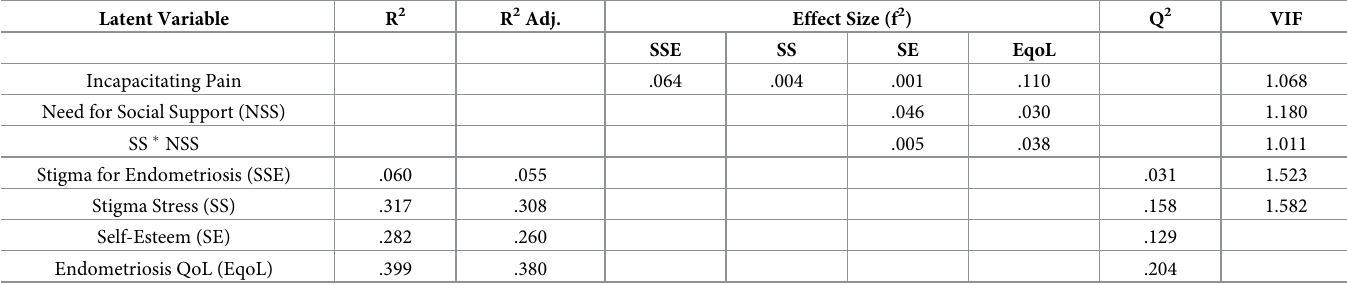
Table 4. Structural model